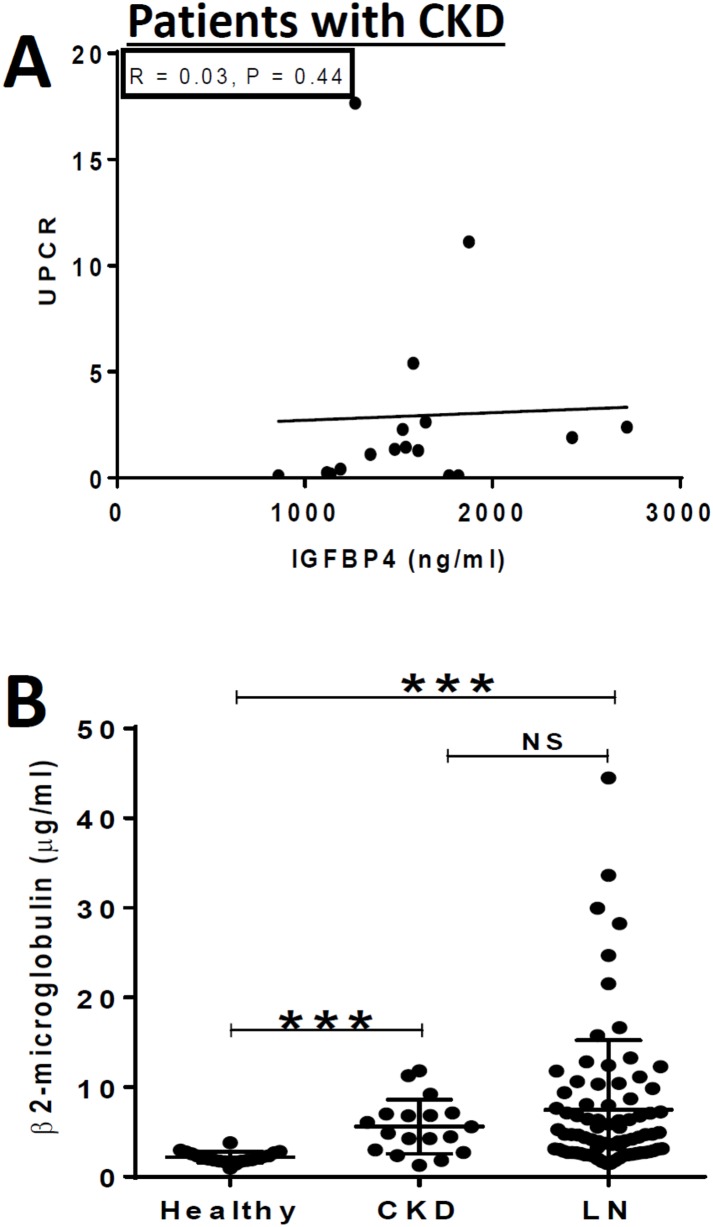
Plotted in (A) are urine protein creatinine ratios (UPCR) versus serum IGFBP4 levels in the CKD control subjects. Plotted in (B) are the serum beta-2-microglobulin levels, as assessed by ELISA, in lupus nephritis patients, healthy controls and CKD controls. Other details are as listed in Fig 1 legend.